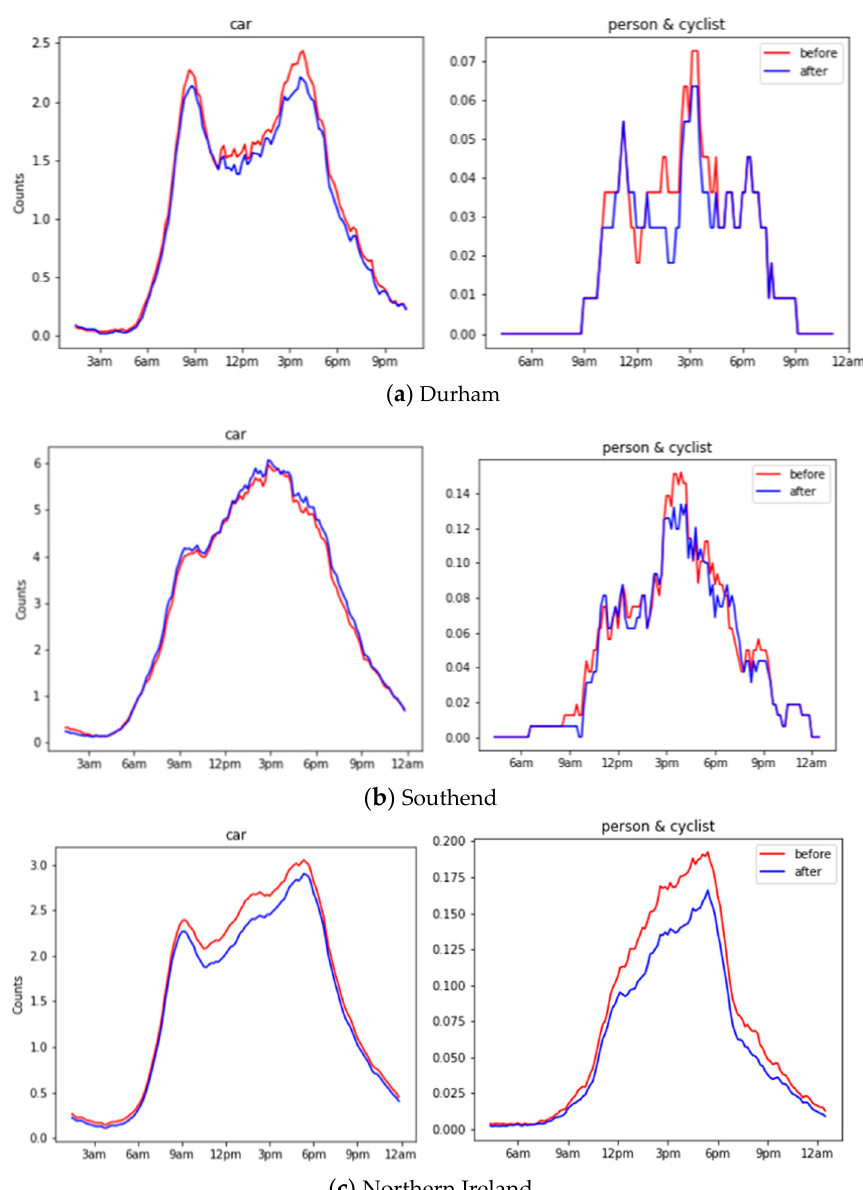
Figure 9. Examples of images before and after down-sampling.